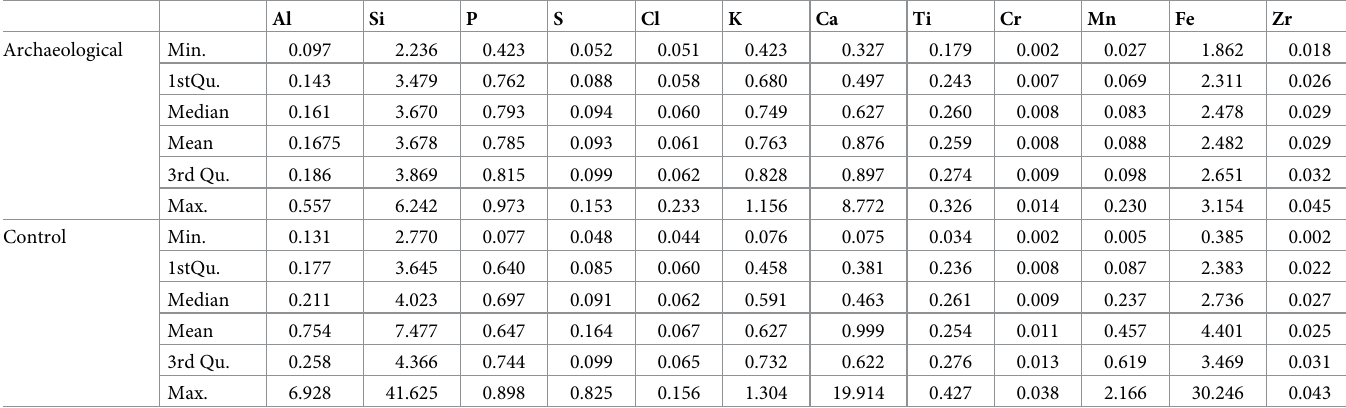
Table 1. Summary statistics of the raw values for archaeological and control samples. Correlation coefficients can be found in S2